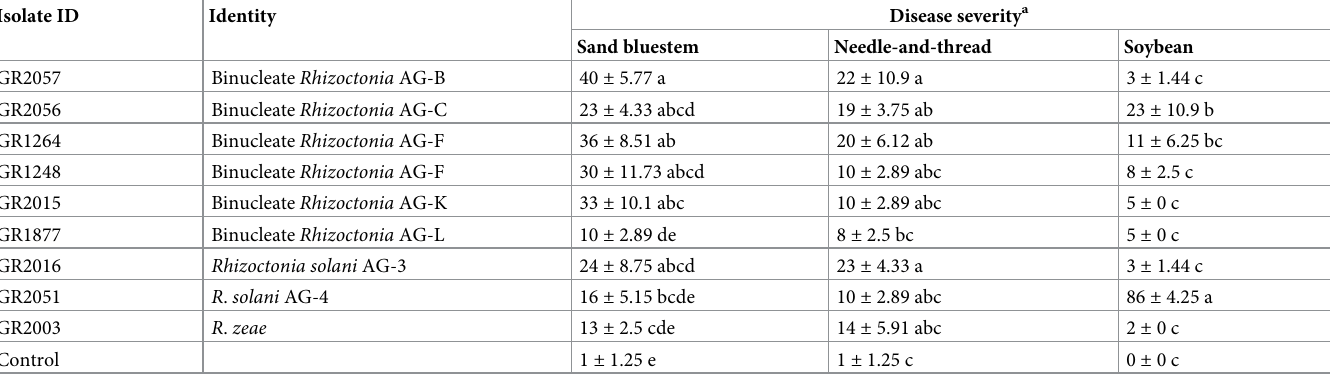
a Percent disease severity ± standard error (SE), means with the same letter within each column are not significantly different (LSD α � 0.05); disease severity is the mean disease severity of replicates of each isolate; disease severity < 5% is considered non-pathogenic, 5 to 20% is mildly aggressive, 21 to 35% is aggressive, and > 35% is highly